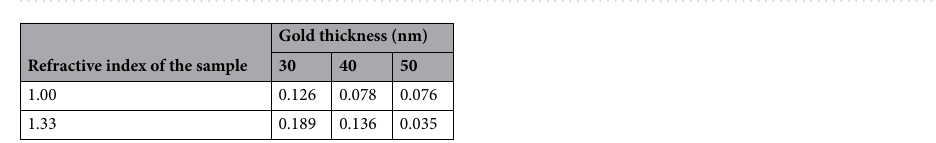
Figure 10. Shows line scans of the simulated phase and the predictive phase profiles in solid curves (the phase from Fresnel calculation) and dash curves (the phase recovered from the CAN). ( a ) n s of 1.00 and ( b ) n s of 1.33.